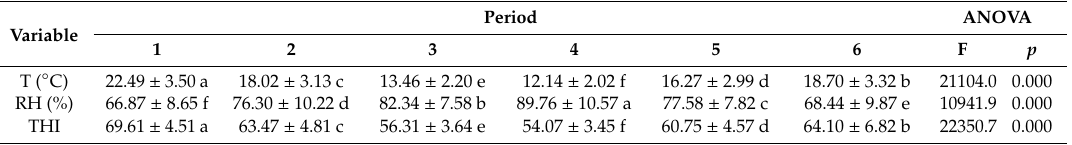
Table 3. Influence of the time of the year on the environmental variables to which the lambs were subjected. For each environmental variable, the values labeled with di ff erent lowercase letters are statistically di ff erent according to the Tukey’s test ( p < 0.05).